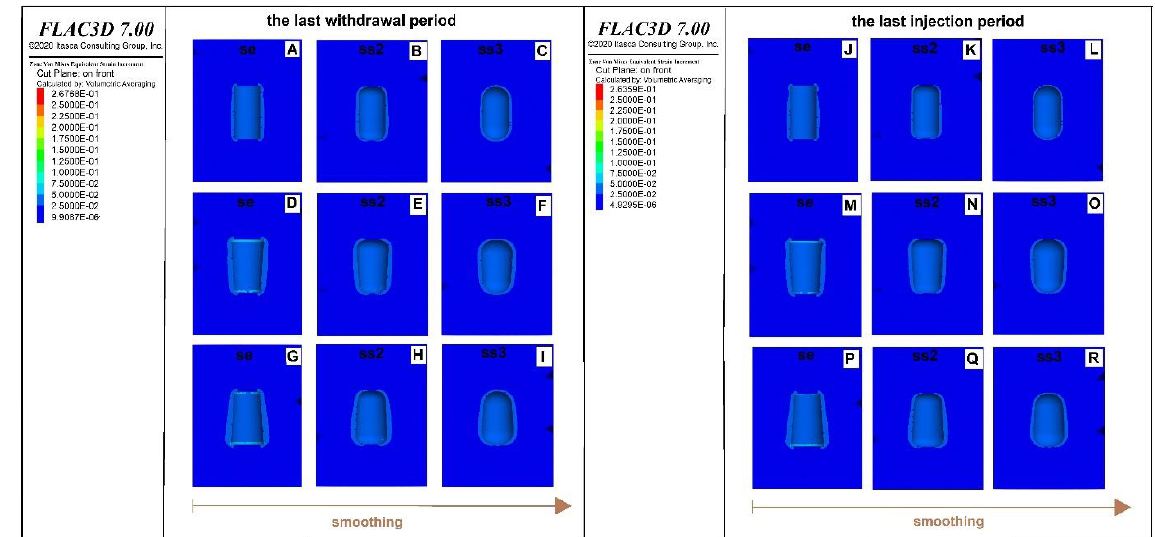
Figure 11. The comparison of the ES between cylindrical and enlarged caverns with a maximum initial diameter of 75 m ( A – R ).